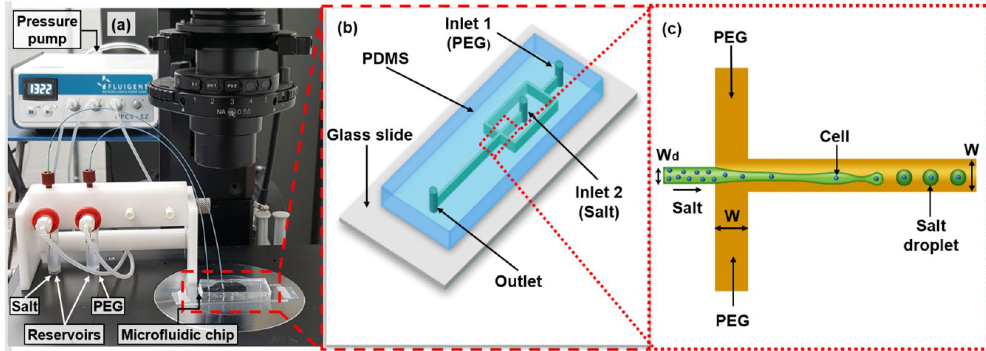
Figure 1. ( a ) Experimental setup including an inverted microscope, a high precision pressure pump, and a microfluidic device. ( b ) Schematic diagram of a microfluidic chip with two inlets and one outlet. ( c ) Schematic diagram of the flow-focusing geometry. Droplets are generated close to the junction and cells are encapsulated inside